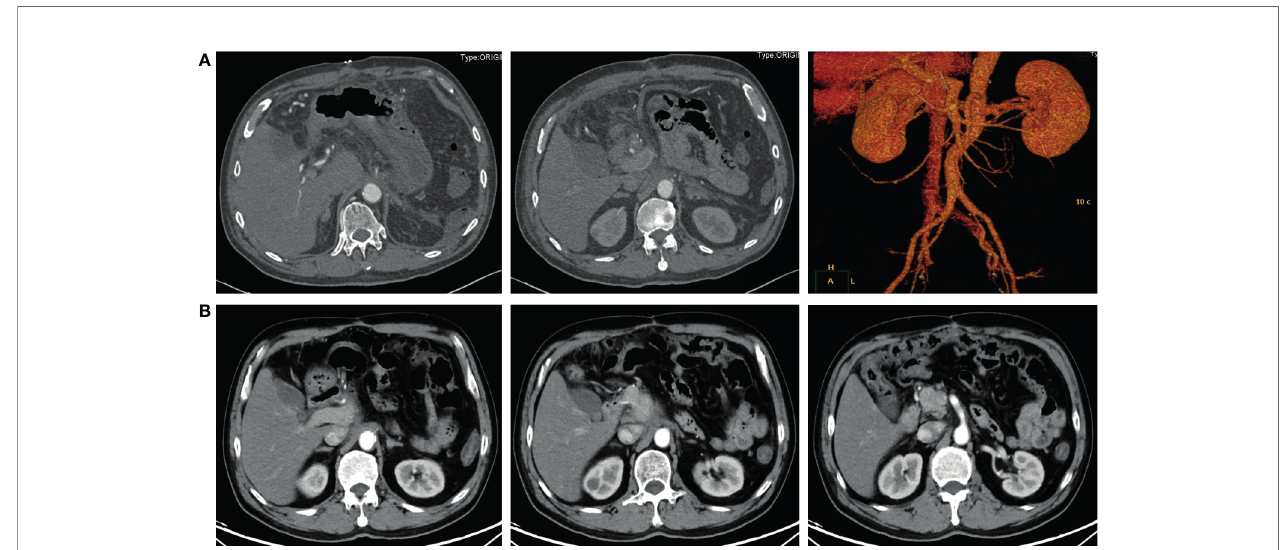
FIGURE 3 | Contrast-enhanced abdominal CT after surgery. (A) 6 days after the radical surgery. The distal pancreas, spleen, and celiac trunk were absent. (B) 8 months after the radical surgery. No signs of recurrence or metastasis were